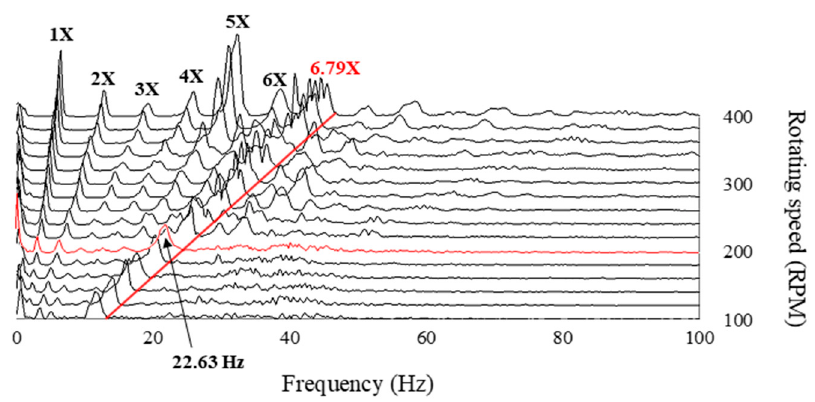
Figure 9. Magnified waterfall plot for the outer ring vibration of Figure 5c.